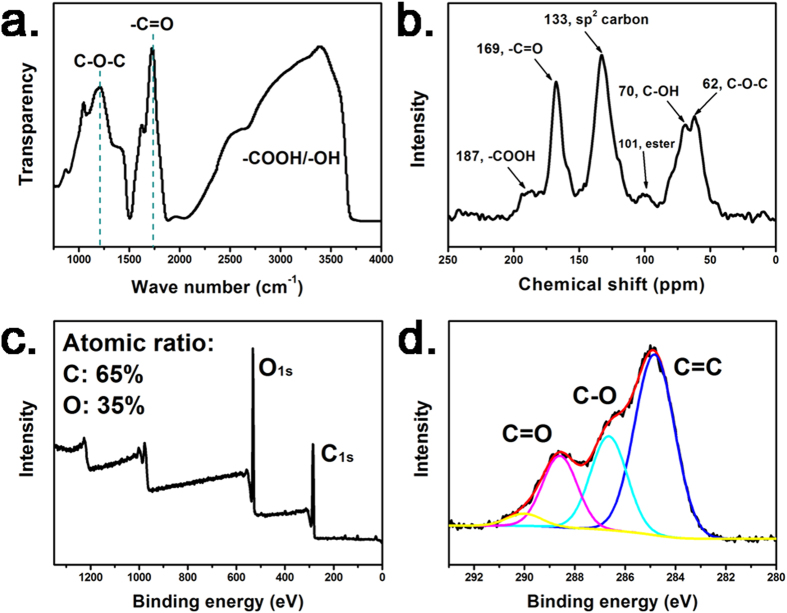
(a) FT-IR, (b) 13C SSNMR, (c) XPS, and (d) C1s spectra of the obtained GQDs.